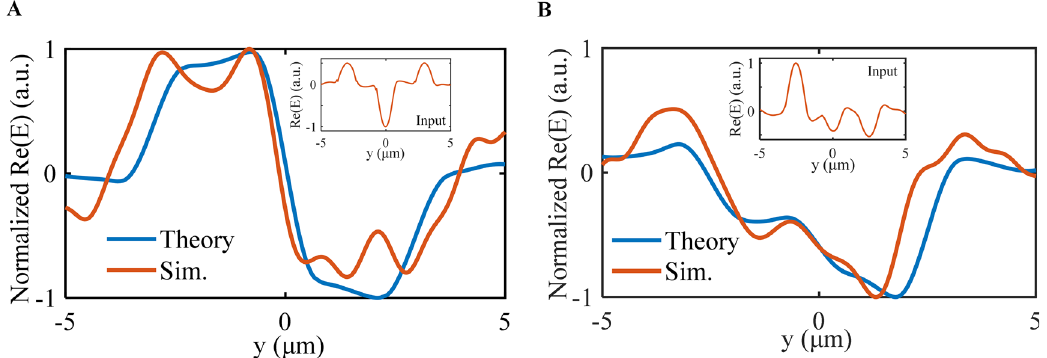
Figure 4: Comparison of simulated and theoretical results under incidences of (A) symmetrical and (B) asymmetrical